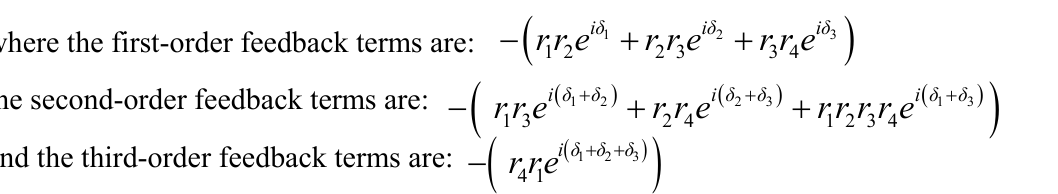
Figure 8. Structure of a multi-layered electro-optic probe (where layers 1 and 3 are thin plates of LiTaO that yield phase modulations δ 3